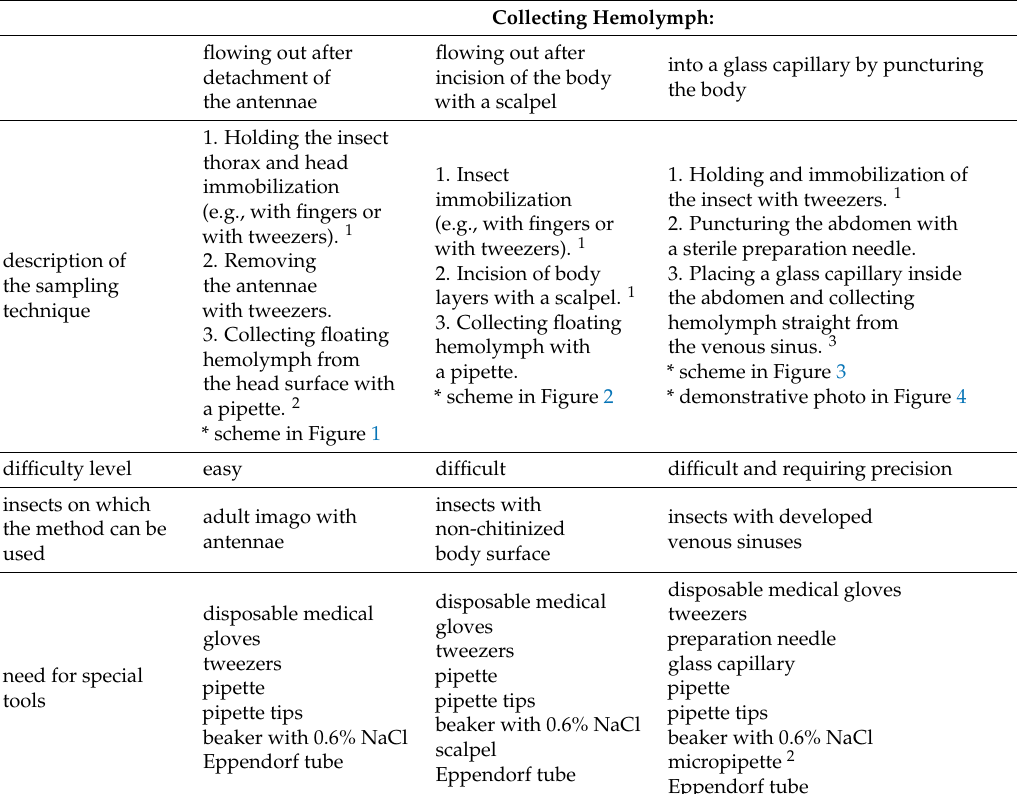
Table 1. Comparison of methods for collecting insect hemolymph